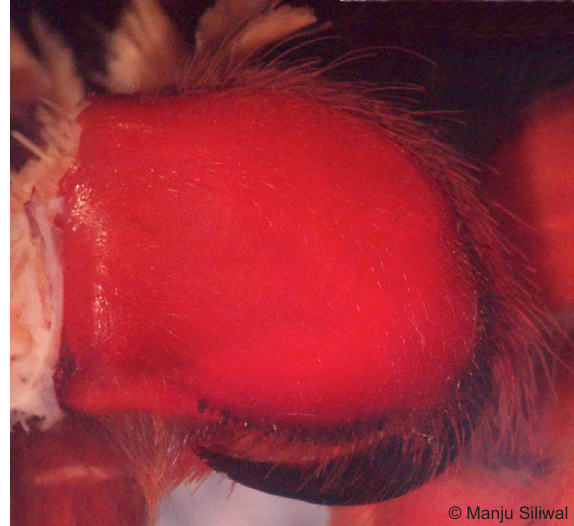
Image 7. Plesiophrictus mahabaleshwari , chelicerae, prolateral view